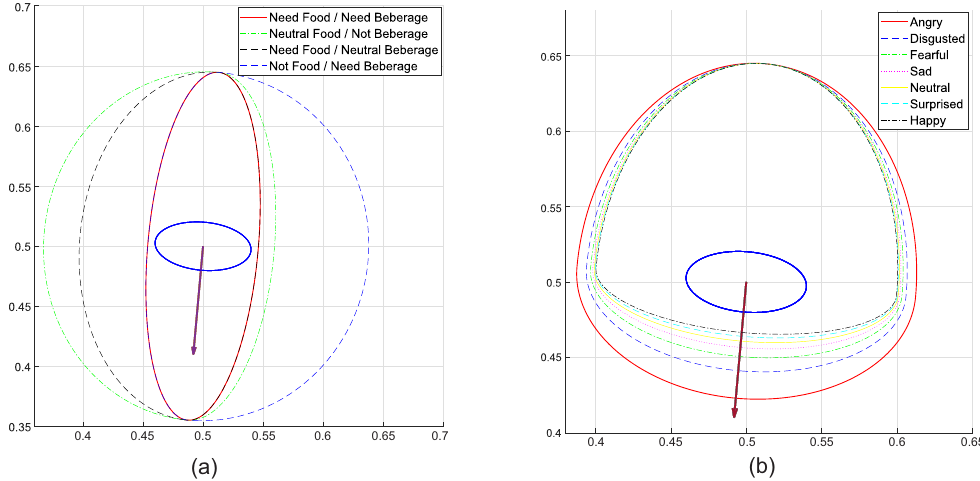
Figure 14. Emotional State: ( a ) Influence of Emotional States into Personal Zone Size; ( b ) Personal Space Influence of Two Features for a Waiter Robot: Diner Food Need and Beverage